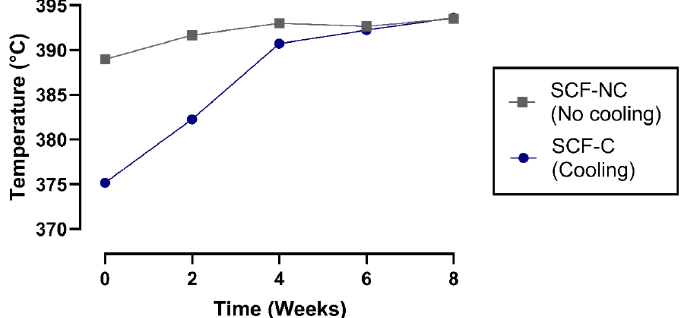
Figure 8. Decomposition temperature of scaffolds. An increase in the decomposition temperature [T 95 ] with time was observed for the SCF-NC and SCF-C groups. The increase in decomposition temperature was 4.52 ◦ C and 18.43 ◦ C for the SCF-NC and SCF-C groups, respectively. The degree of crystallinity was obtained based on DSC for the SCF-NC and SCF-C groups at weeks 0, 2, 4, 6, and 8 (see Figure 9). For week 2 of the immersion period, the crystallinities calculated were 38.1% and 30.4% for the SCF-NC and SCF-C groups, respectively. By week 8, the groups presented an increment of crystallinity of 14.3% for the SCF-C group, and 5.2% for the SCF-NC group with respect to week